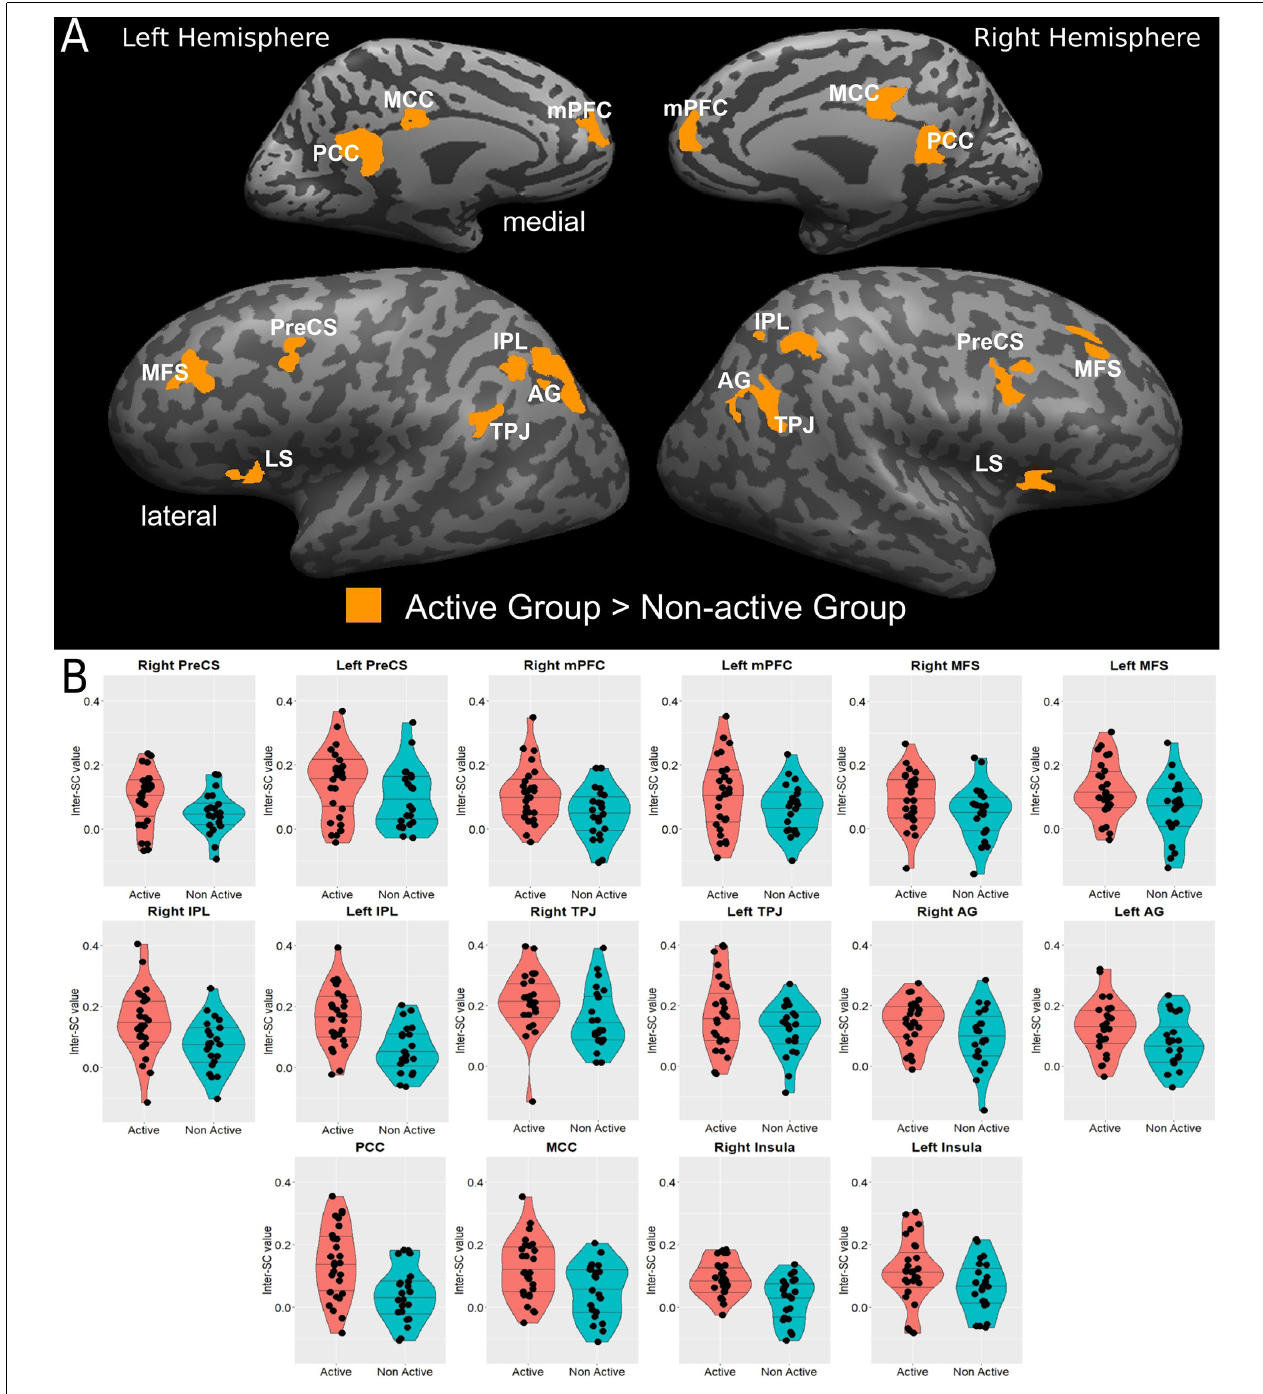
FIGURE 2 | (A) Statistical brain map of between-group differences in inter-SCs during complex information processing. (B) Violin plots of between-group differences in the inter-SC values in significantly different regions are presented in (B) ; horizontal lines represent 25%, 50%, and 75% quantile. AG, angular gyrus; IPL, inferior parietal lobule; LS, lateral sulcus/insular cortex; MCC, middle cingulate cortex; MFS, middle frontal sulcus; mPFC, medial prefrontal cortex; PCC, posterior cingulate cortex; PreCS, precentral sulcus; TPJ, temporoparietal